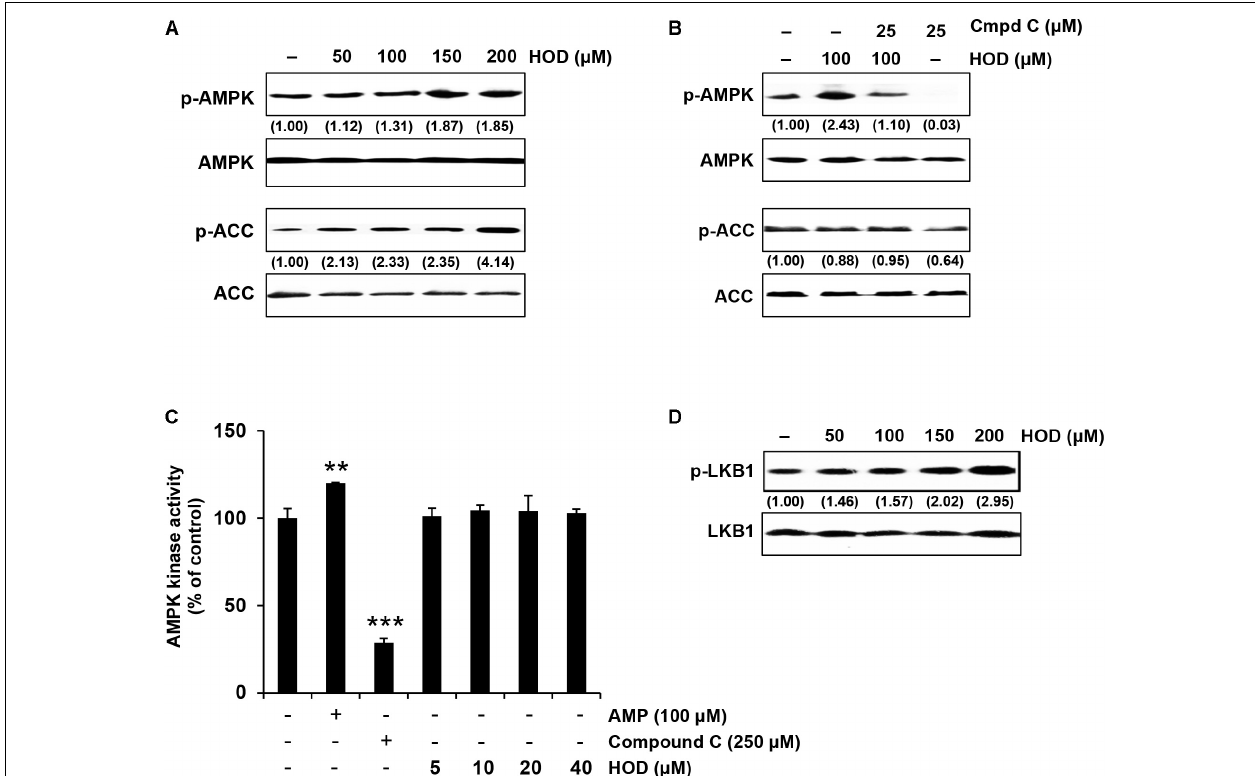
FIGURE 3 | HOD activates the LKB1/AMPK signaling pathway. (A) HOD stimulates the phosphorylation at Thr172 of AMPK α and Ser79 of its down-stream target ACC in HepG2 cells. (B) Compound C, an AMPK inhibitor, blocks HOD-induced AMPK phosphorylation. The cells were exposed to 100 µ M HOD for the indicated period with or without 25 µ M compound C. (C) AMPK kinase activity using human recombinant AMPK was performed. Significance: ∗∗ p < 0.01; ∗∗∗ p < 0.001 vs. control. (D) HOD stimulates the phosphorylation at Ser428 of